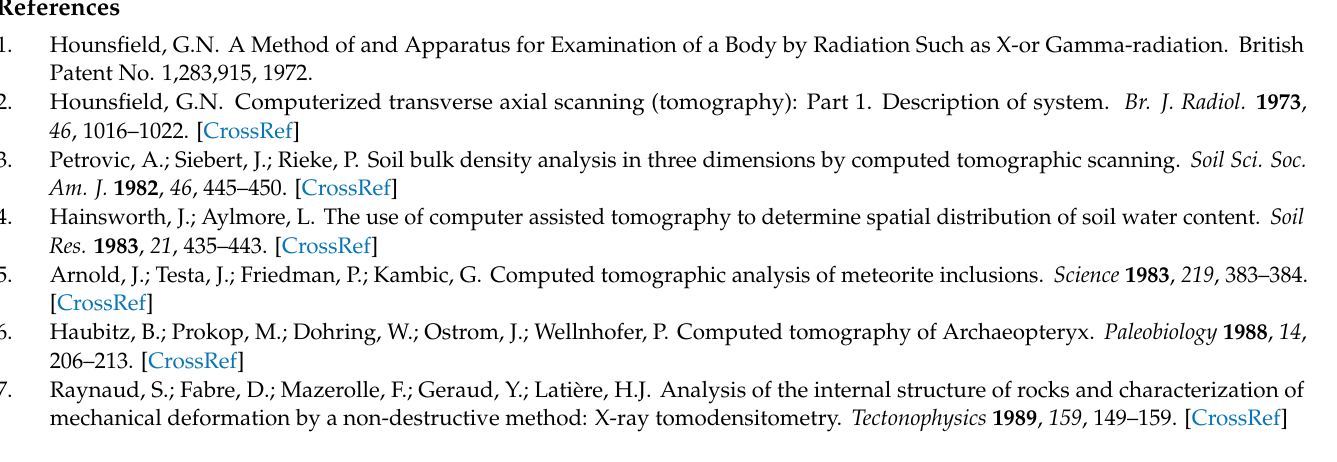
Figure A3. Comparison of 2 classes of C ( CH, CL ) samples with T samples ( T ) in Sliced Wasserstein metric in 3D coordinates (left figure) and example of sample’s slices with different binarization threshold. A denotes A sample, SB —Sandstone, numbers denote threshold, underscore denotes the number of subsample (right